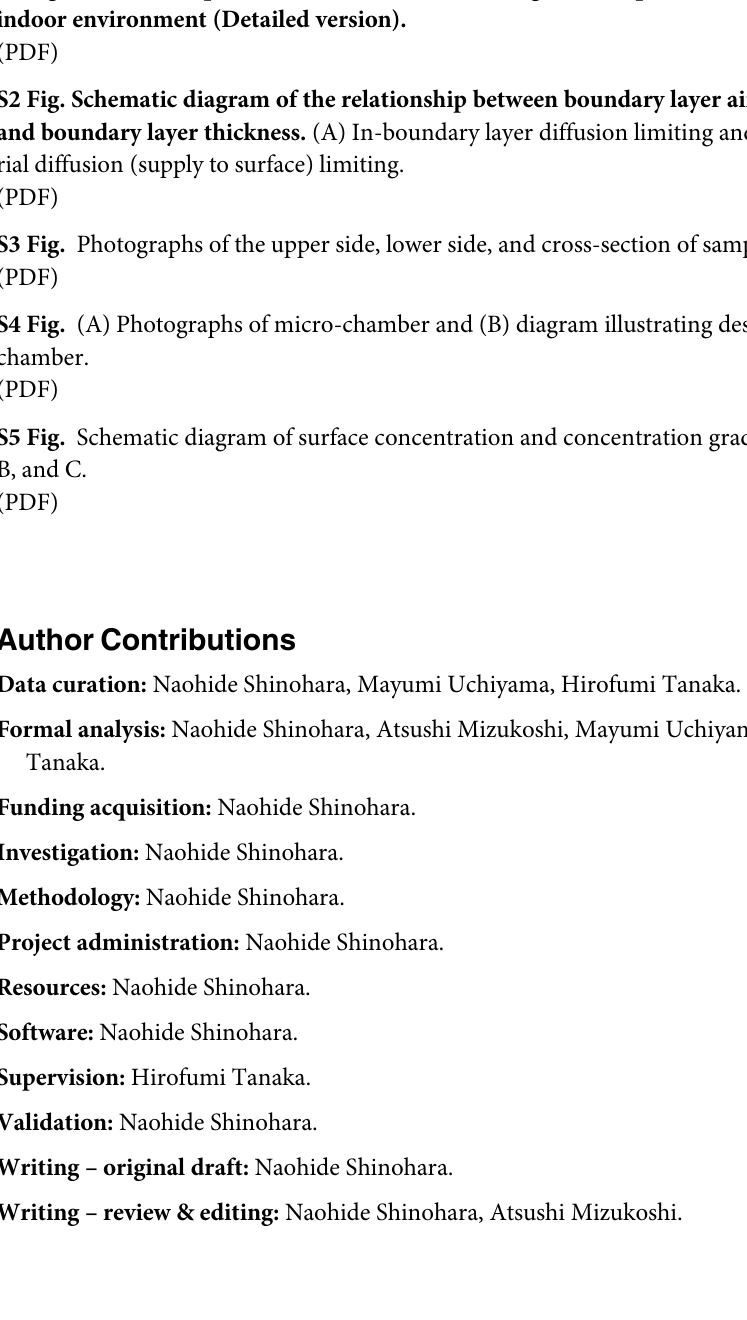
S1 Table. Raw data of total emission amount during 7 days. (PDF) S2 Table. Raw data of emission rates for different boundary thickness. (PDF) S3 Table. Raw data of emission rates in the micro-chamber test. S1 Fig. Schematic representation of semi-volatile organic compounds (SVOCs) in an indoor environment (Detailed version). S2 Fig. Schematic diagram of the relationship between boundary layer air concentration and boundary layer thickness. (A) In-boundary layer diffusion limiting and (B) Inside-mate- rial diffusion (supply to surface) limiting. S3 Fig. Photographs of the upper side, lower side, and cross-section of samples A, B, and C. (PDF) S4 Fig. (A) Photographs of micro-chamber and (B) diagram illustrating design of micro- chamber. S5 Fig. Schematic diagram of surface concentration and concentration gradient for sample A, B, and C.